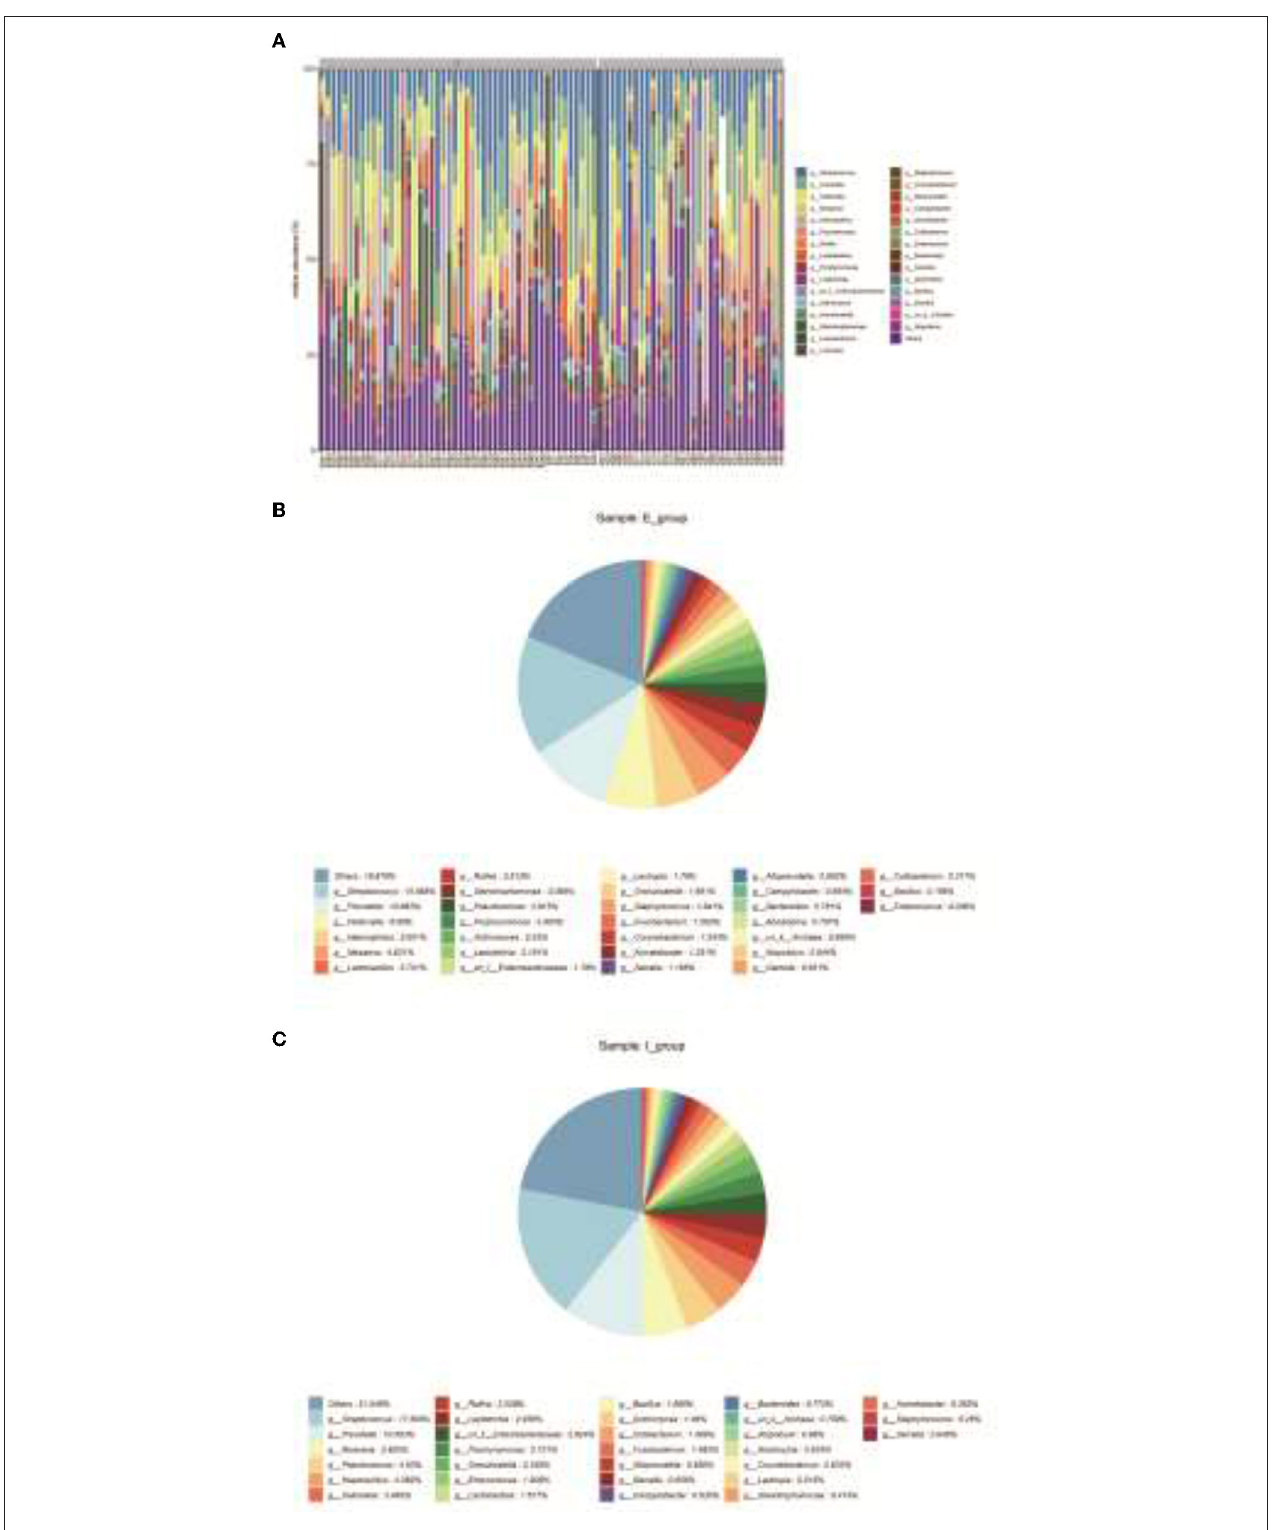
FIGURE 3 | Clustering of bacterial species. (A) , Community compositions of both sample groups were analyzed and there were 30 primary bacterial species identified in the samples of the two groups. (B) , Relative abundance of intestinal dominant flora and cluster analysis of species in COPD frequent exacerbators at the genus level. (C) , Relative abundance of intestinal dominant flora and cluster analysis of species in COPD infrequent exacerbators at the genus level. E represented COPD frequent exacerbators; I represented COPD infrequent exacerbators. COPD, chronic obstructive pulmonary disease.